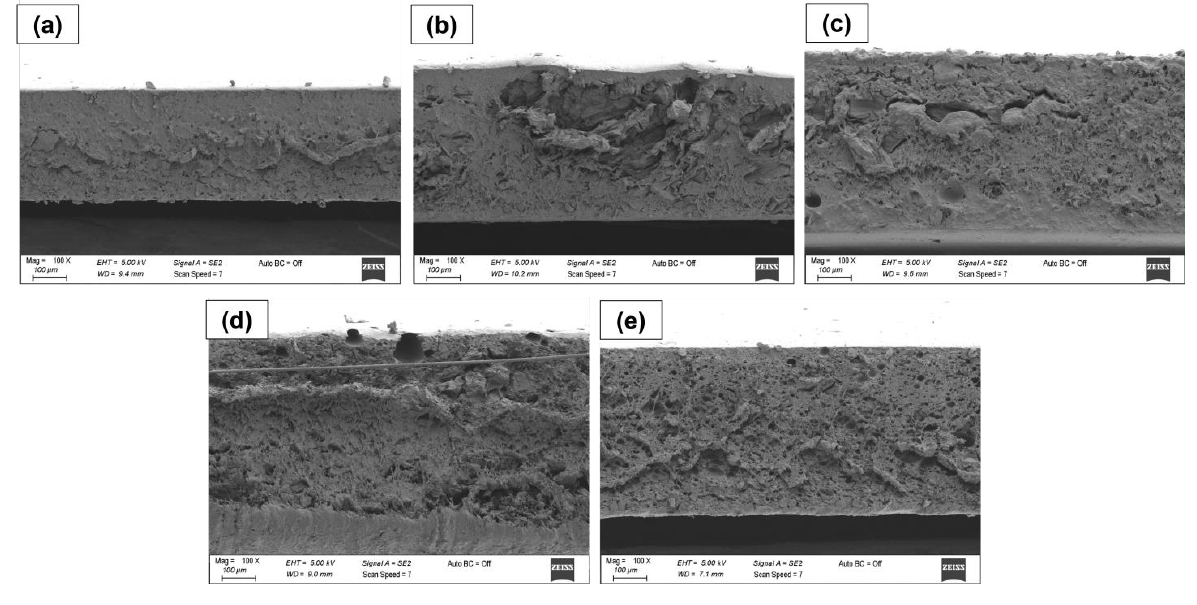
Figure 4. Cross-sectional SEM images of the ( a ) PI film, ( b ) PIP film, ( c ) PIP-N1 Pickering film, ( d ) PIP-N3 Pickering film, and ( e ) PIP-N5 Pickering film.